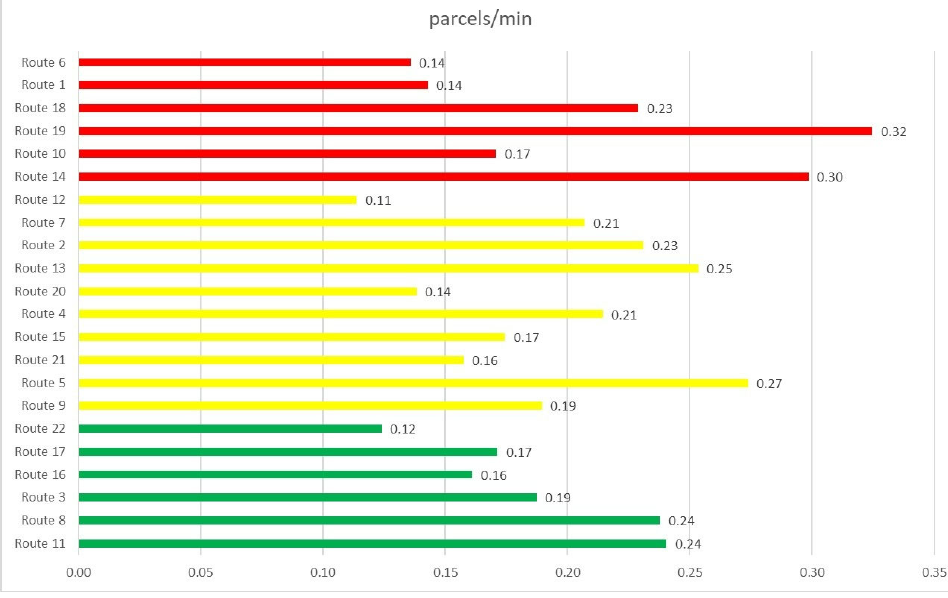
Figure 7. Individual couriers’ efficiency at particular route. Colors represents: green—group A, yellow—group B, red—group C Source: Own study.